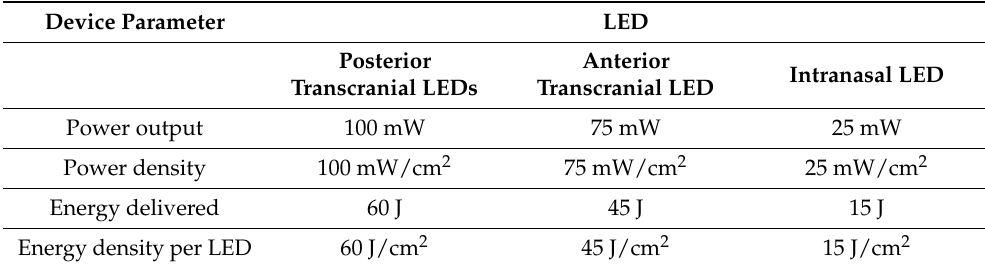
Table 2. Parameters of the Vielight PBM device (LED, Light-Emitting